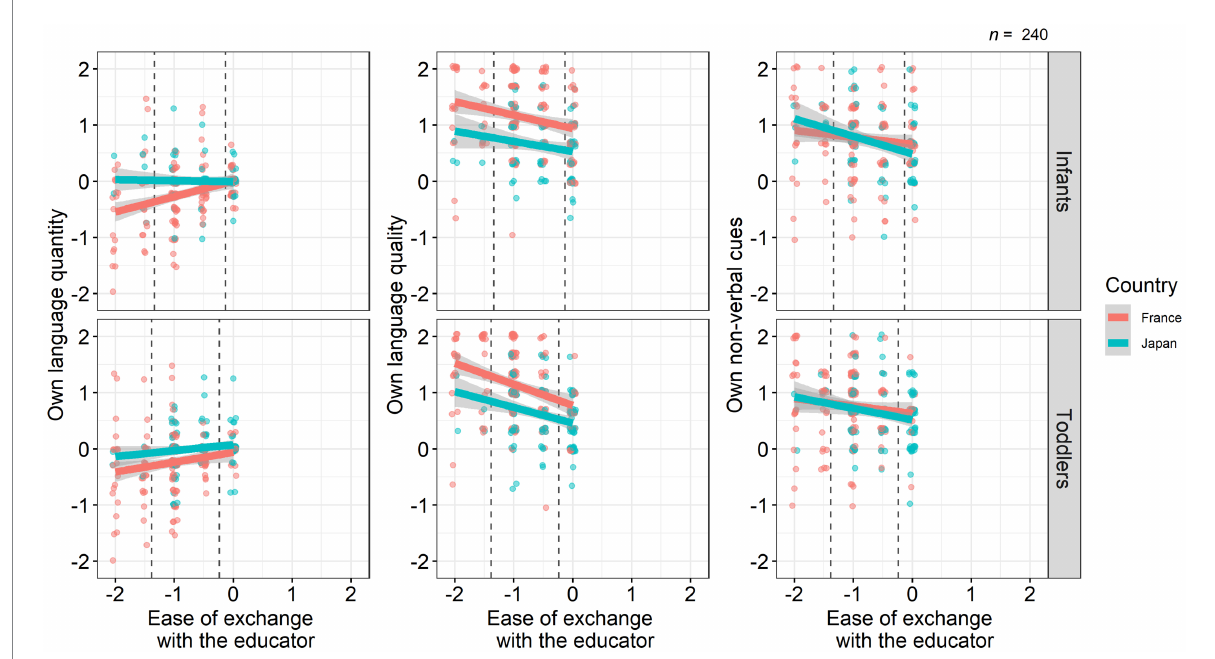
FIGURE 2 The relationship between children’s ease of exchange and educators’ own communicative behavior. Dot clusters represent individual data points. The lines and gray zones represent the regression lines and 95% confidence intervals, respectively. Dashed lines represent mean ± 1 SD in ease of exchange with the